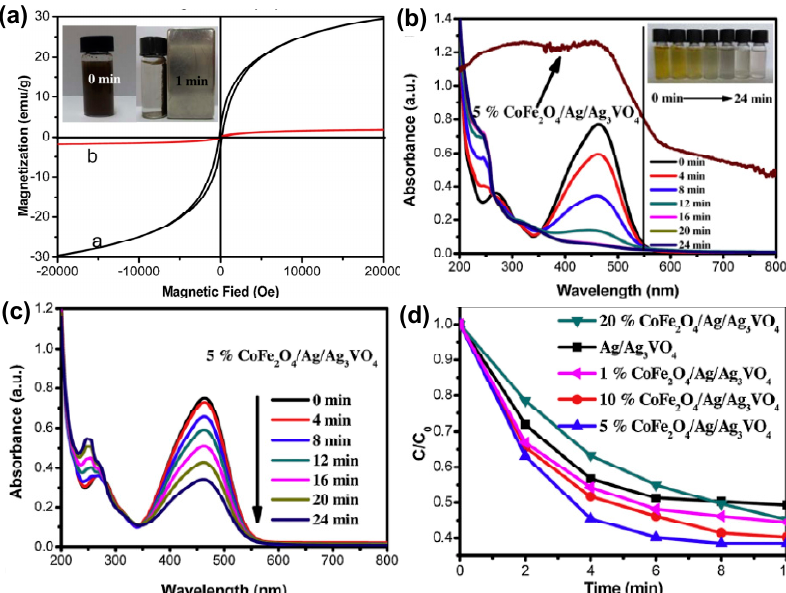
Figure 18. ( a ) Magnetic separation performance of the CoFe 2 O 4 /Ag/Ag 3 VO 4 composite. ( b ) The absorption spectra of methyl orange solutions over time in the presence of CoFe 2 O 4 /Ag/Ag 3 VO 4 (under visible light λ ≥ 440 nm) and the UV–vis absorption spectrum of CoFe 2 O 4 /Ag/Ag 3 VO 4 . ( c ) The evolution of the absorption spectra of methyl orange solutions over time in the presence of CoFe 2 O 4 /Ag/Ag 3 VO 4 (under visible light λ ≥ 550 nm). ( d ) Photocatalytic degradation of tetracycline with different samples under visible light irradiation. Adapted with permission from Reference [95] Copyright (2016) Elsevier.